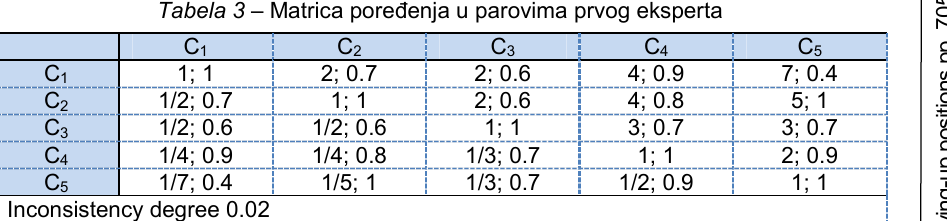
Table 3 – Comparison matrix in the pairs of the first expert Таблица 3 – Матрица парного сравнения первого эксперта